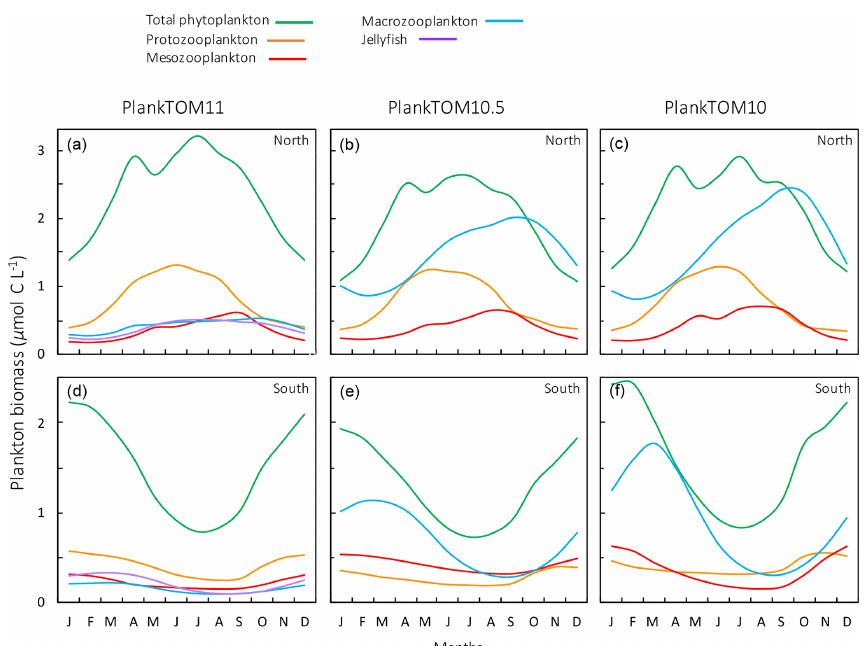
Figure 11. Seasonal surface carbon biomass (µmolCL − 1 ) of total phytoplankton PFTs, protozooplankton, mesozooplankton, macrozoo- plankton and jellyfish. For PlankTOM10.5, the MAC PFT has been summed with the 11th PFT that duplicates MAC. Panels shown PFT biomass for PlankTOM11 (a, d) , PlankTOM10.5 (b, e) and PlankTOM10 (c, f) for two regions; the north, 30–70 ◦ N (a–c) , and the south 30–70 ◦ S (d–f) , across all longitudes. All data are averaged for